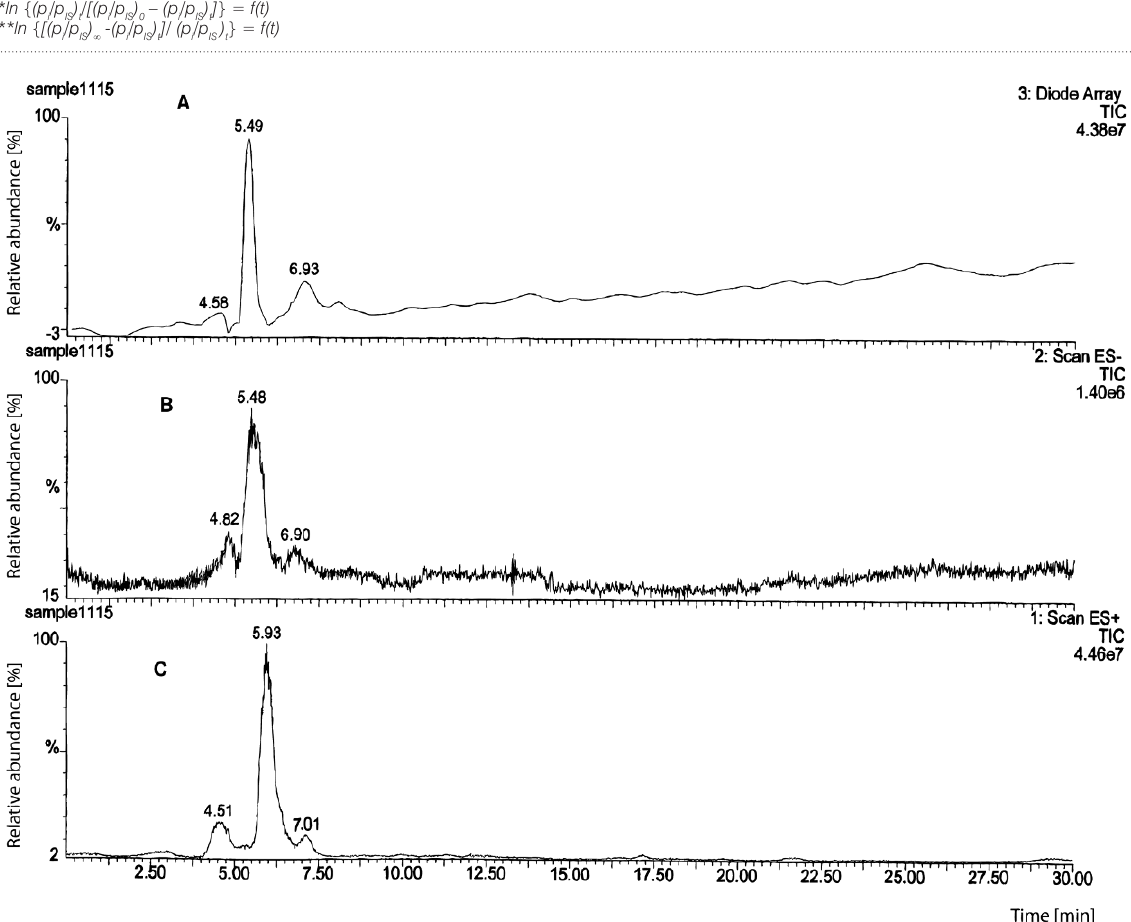
Figure 4. LC-MS chromatogram for IMD after 6 h of heating under T = 363 K and RH = 76.4% (A) detected by UV absorption using mass spectrometric total ion current (TIC); (B) acquired in negative ES- TIC mode; (C) acquired in positive ES+ TIC